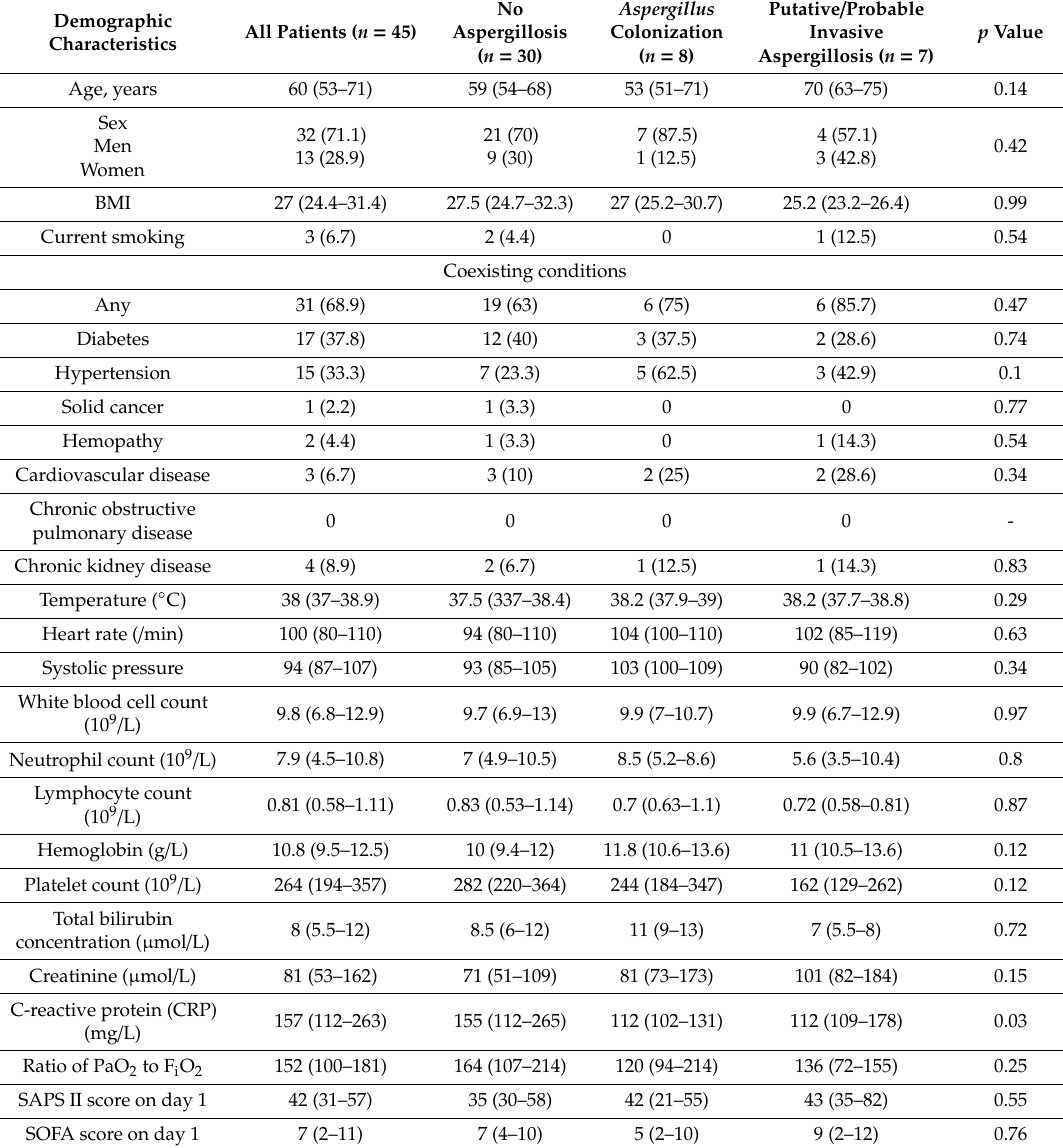
Table 3. Demographic characteristics and clinical and biological baseline